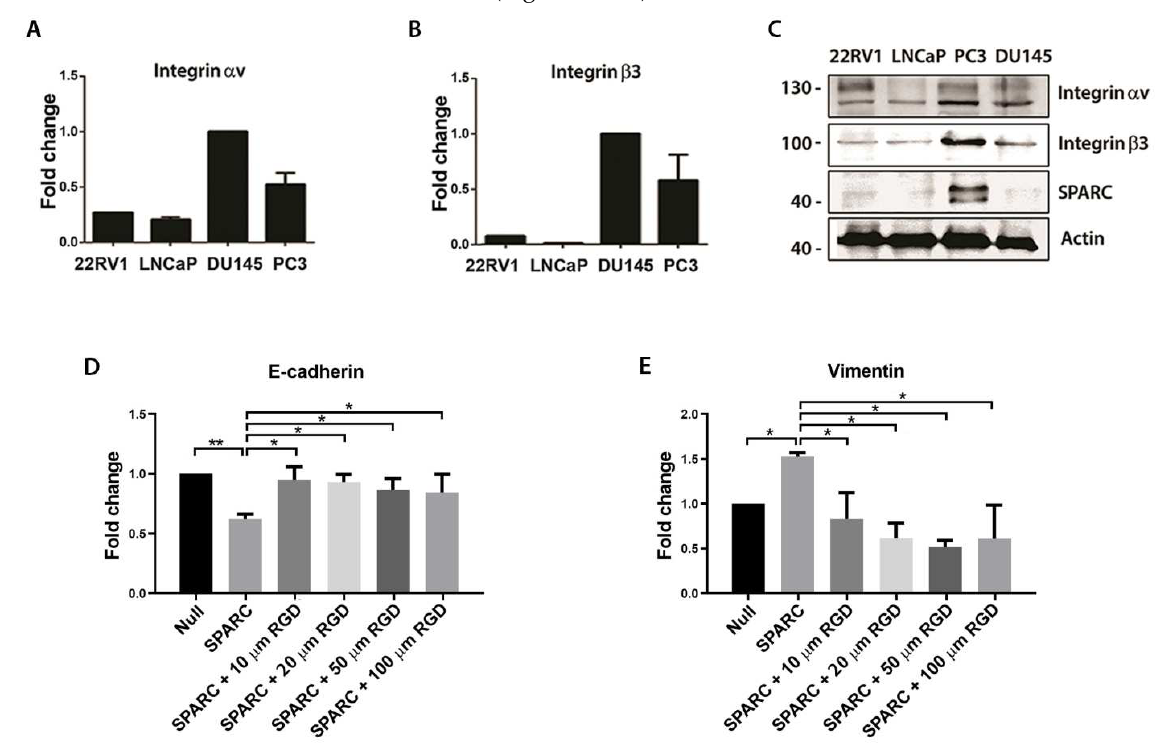
Figure 3. Expression of integrin α v β 3 subunits in prostate cancer cell lines and its effect on the inhibi- tion of E-cadherin ( A , B ). Relative expression of integrin α v (left) and β 3 (right) subunits measured by RT-qPCR in the prostate cancer cell lines 22RV1, LNCaP, PC3 and DU145 ( C ). Representative Western blot of integrin α v, β 3 subunits and SPARC in different prostate cancer cell lines ( D , E ). Relative expression of E-cadherin ( D ) and vimentin measured by RT-qPCR in the prostate cancer cell LNCaP. LNCaP cells overexpressing SPARC were incubated with different concentrations of RGD peptide ( A , B , D , E ). Relative expression was normalized to pumilio and control cells (first column) using the ∆∆ Ct method. Data are expressed as mean ± SD ( n = 3). ns = p > 0.05; * = p ≤ 0.05; ** = p ≤